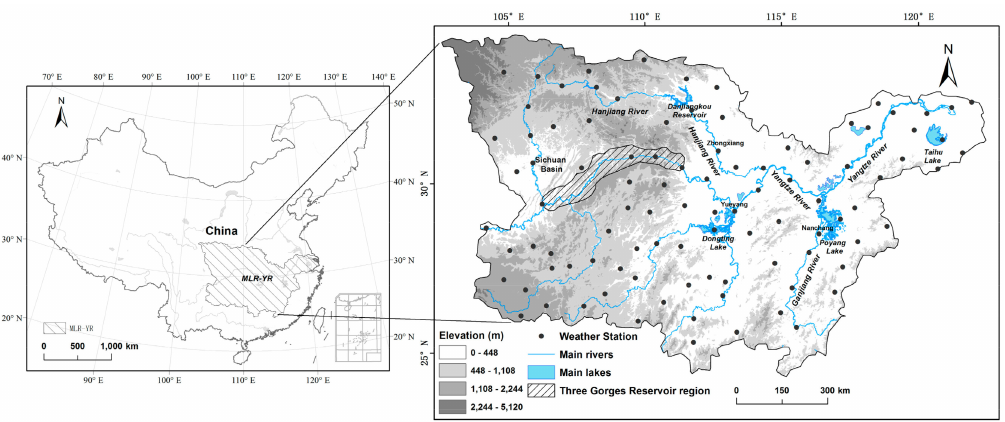
Figure 1. Location of the middle and lower reaches of the Yangtze River